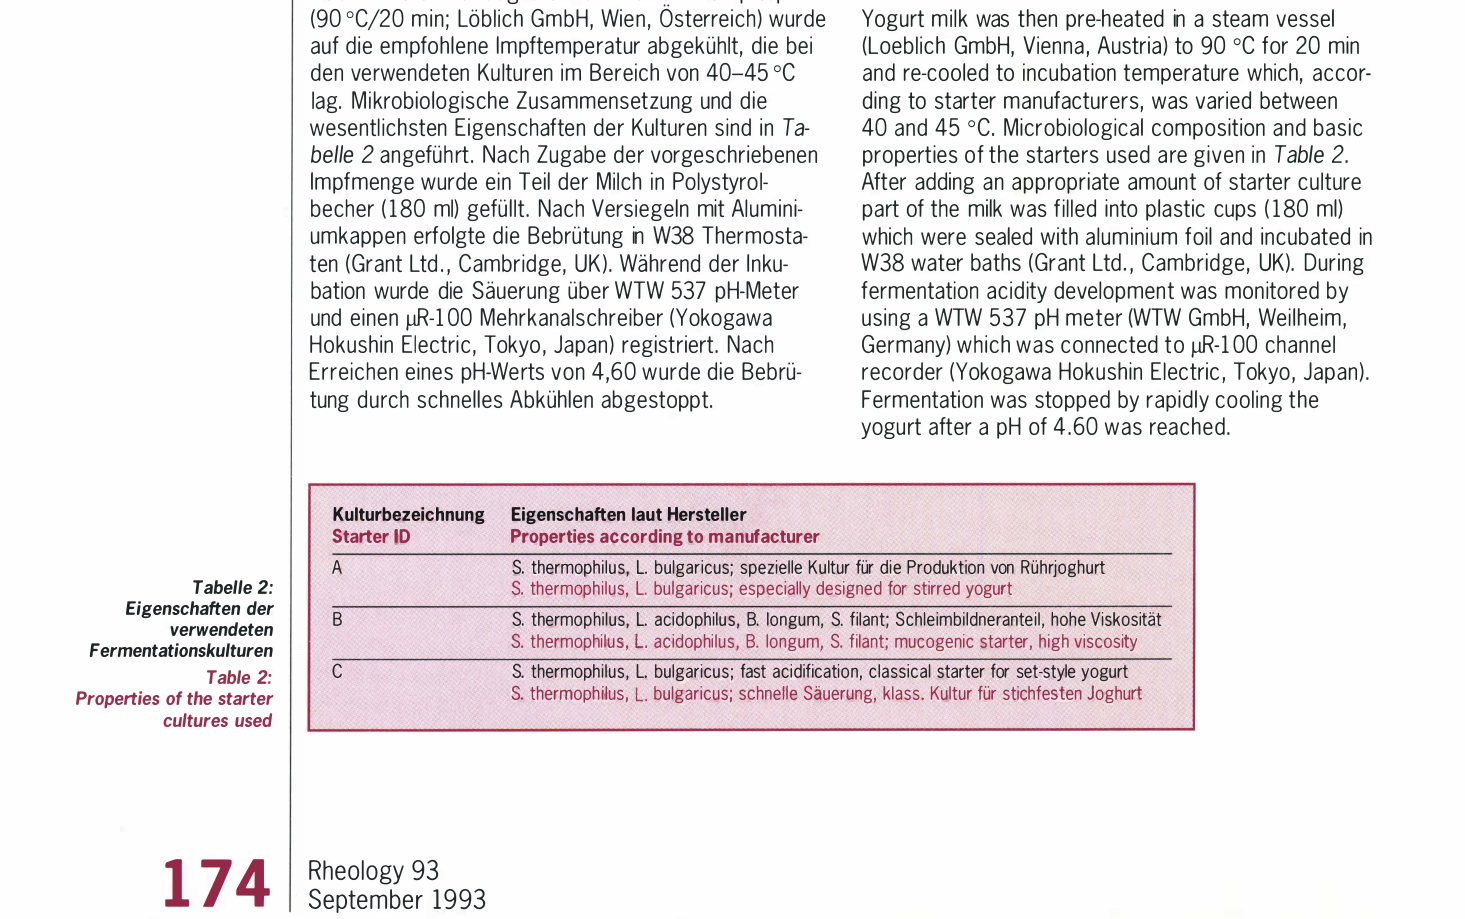
Tabel/e 2: Eigenschaften der verwendeten Fermentationskulturen Table 2: Properties of the starter cultures